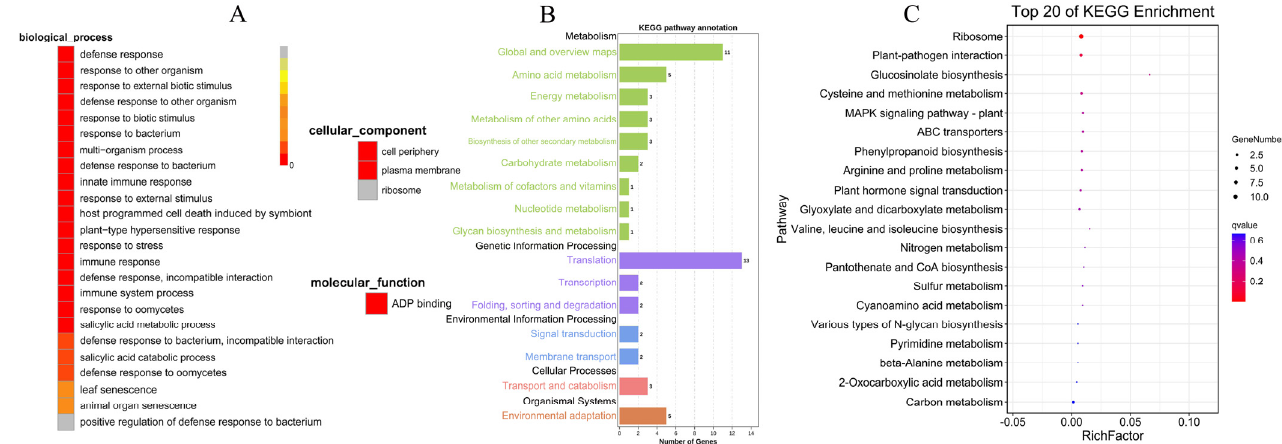
Figure 3. Enrichment analysis of DEGs. ( A ) GO enrichment analysis of DEGs for cellular component, biological process, and molecular function. ( B ) Functional classification of DEGs based on KEGG pathways. X axis represents number of DEGs, whereas Y axis indicates second KEGG pathway terms. ( C ) KEGG enrichment of DEGs. The color and size of dots represent the q -value and the gene number,